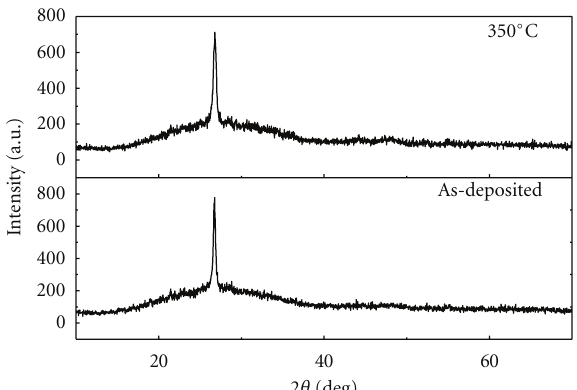
Figure 3: XRD patterns of Cd 1 − x Zn x S prepared under the optimum conditions before and after